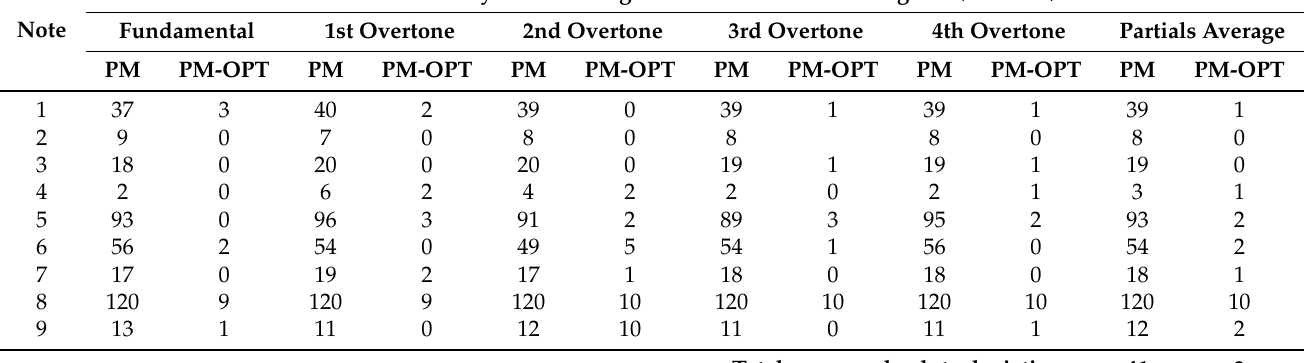
Table 3. The absolute deviation (in cents) of the synthesized signals, without adopting the optimal correction factors (PM) and after adopting the optimal correction factors (PM-OPT), from the recording signals for the 9 notes, the average absolute deviation of all the partials between the recorded and the synthesized signals for the 9 notes and the total average absolute deviation for all the partials and